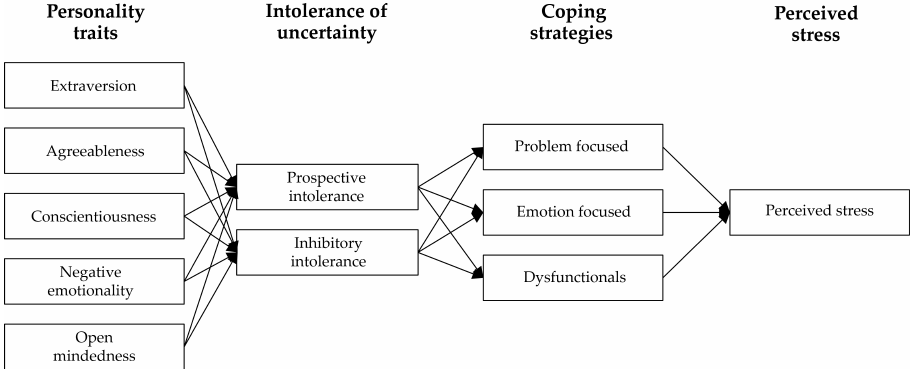
Figure 1. Path-diagram of the general model of structure of relations among